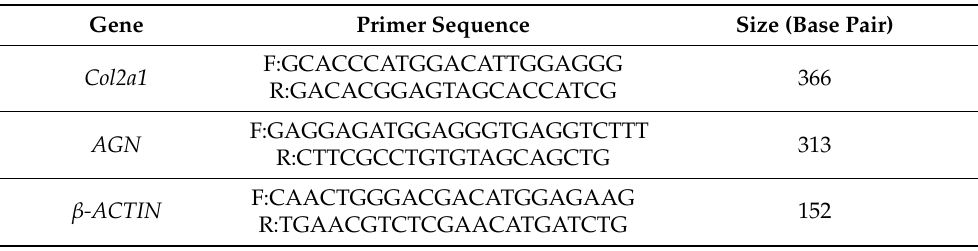
Table 1. The relative change in gene expression was determined via the comparative 2 – ∆ C T method, where = CT, target—CT, β -actin and β -actin was used as the internal control. Table 1. Primers for rabbit chondrogenic marker messenger RNA (mRNA) detection.